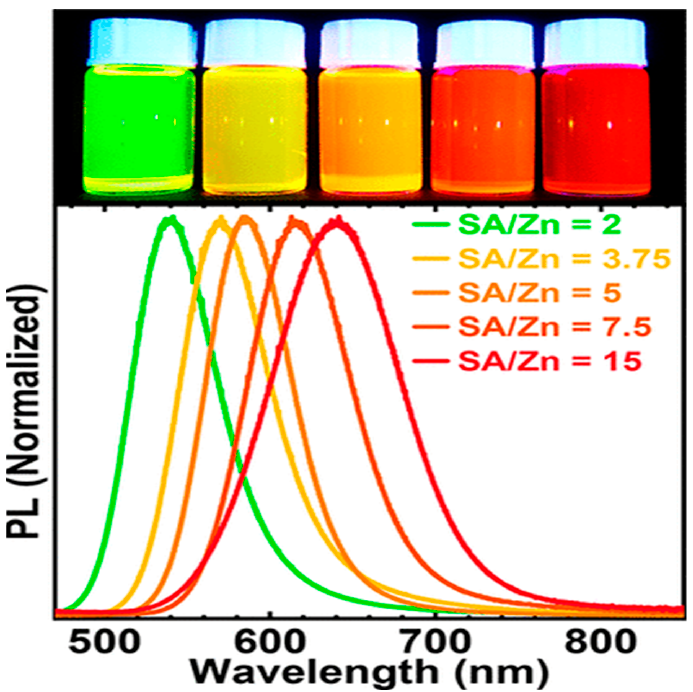
Figure 3. Photoluminescence spectra of In(Zn)As/ZnSe/ZnS QDs synthesized with different amounts of stearic acid (SA) ligand relative to the initial zinc precursor under UV illumination (Reproduced from [92], with permission from ACS Publications).